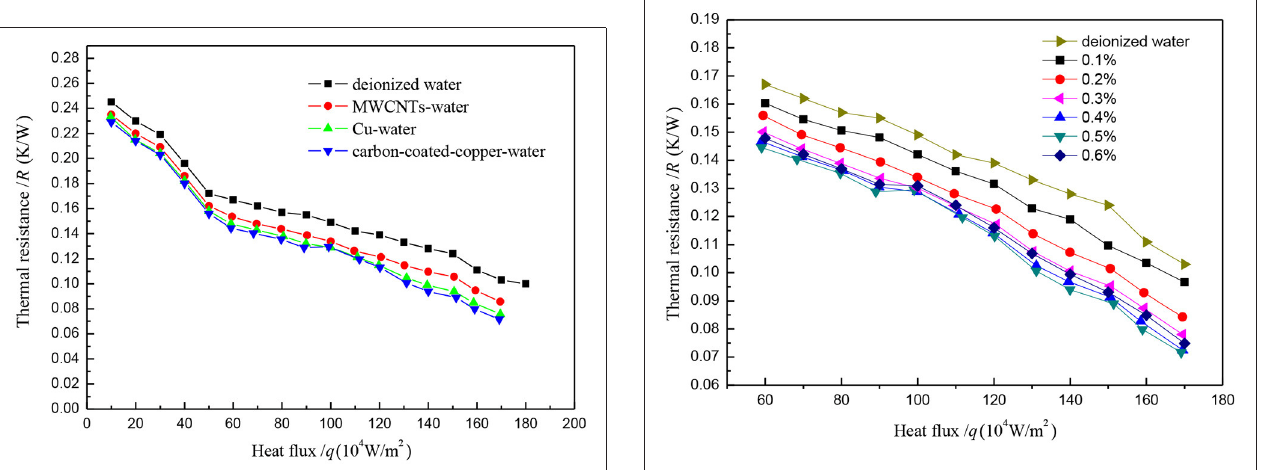
FIGURE 5 | Change of thermal resistance of different medium of the FPHP.